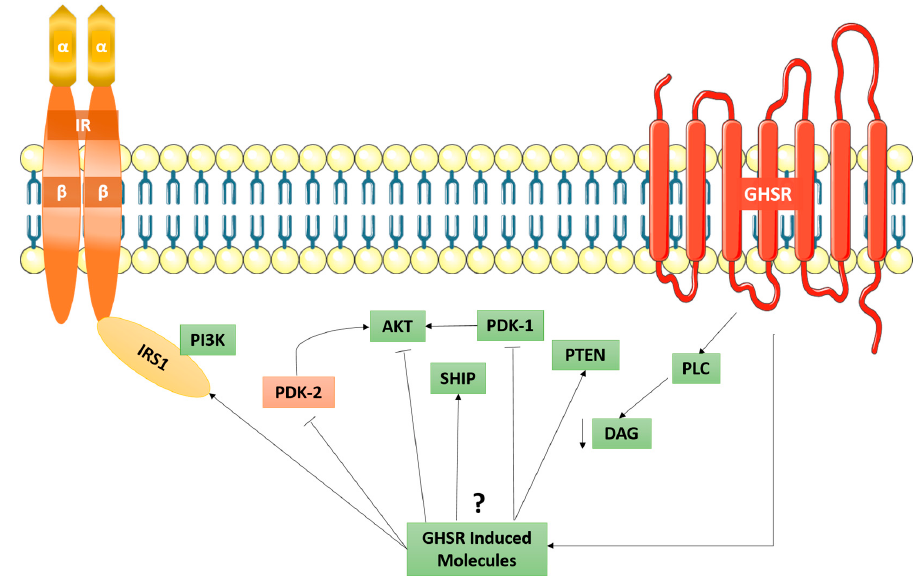
Figure 6. Proposed GHSR induced mechanism of signal transduction in relation to the IR. Here, the possible GHSR-induced molecules are shown to exert their effects by activating or inhibiting several signalling pathways. More importantly, it has been proposed that the inhibiting mechanism of AKT kinase by ghrelin is responsible for the disassociation of the IRS1-PI3K-AKT pathway. Taken in part from Murata et al. [64].